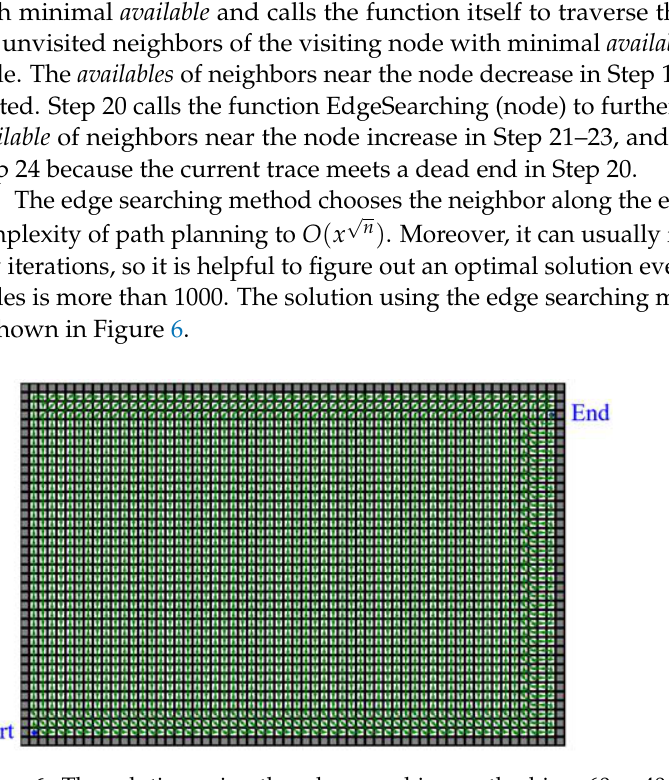
Figure 6. The solution using the edge searching method in a 60 × 40 m 2 region. The gray grids represent inaccessible nodes, and the white grids represent the target nodes. The optimal trace is drawn as green arrows, and the blue points show the beginning and the end of the trace.